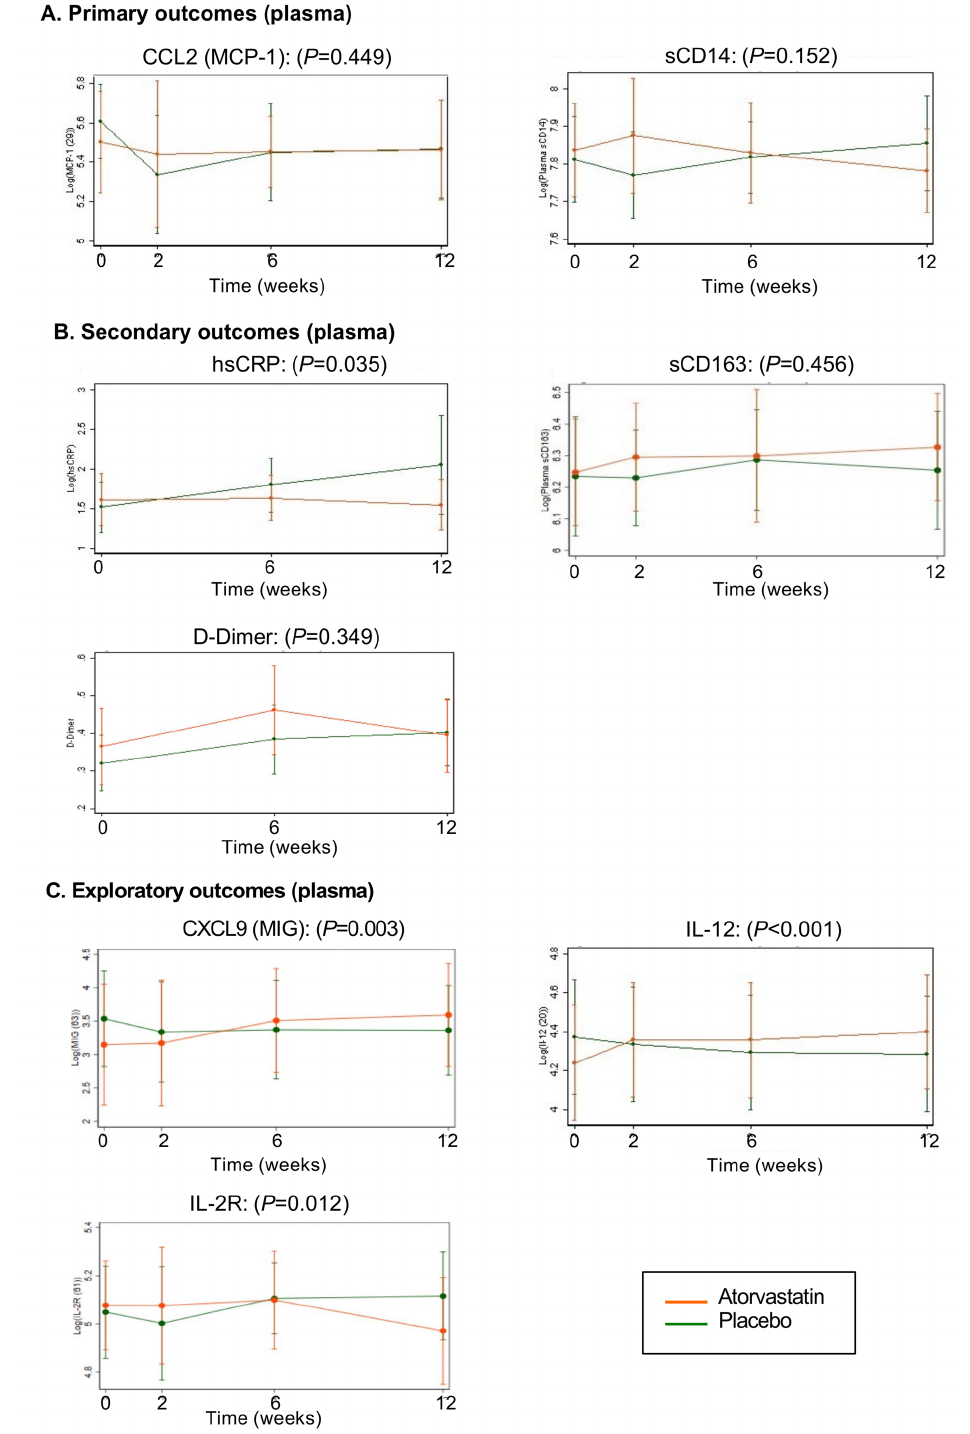
Figure 3. Effect of atorvastatin treatment on plasma inflammatory markers: Shown are the predefined primary outcomes (A) and secondary outcomes (B), along with exploratory outcomes that reached a nominal P ≤0.05 threshold (C). Data represent the mean biomarker levels by study arm with 95% confidence intervals, with atorvastatin shown in red and placebo in green. Raw P value of the difference between the 2 groups over 12 weeks is